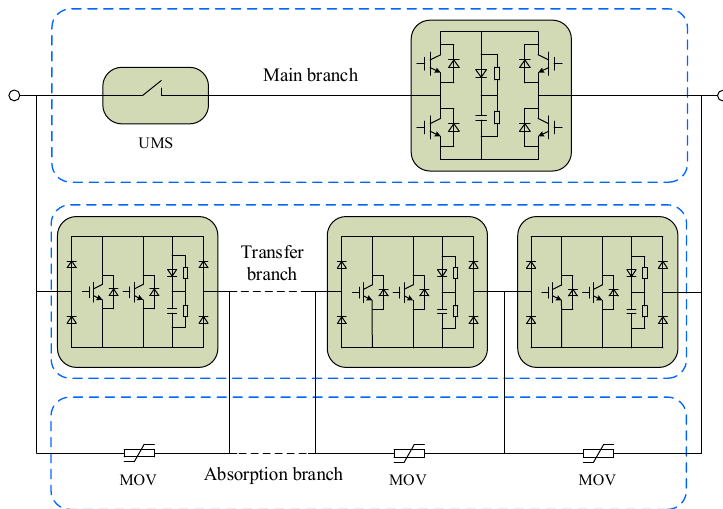
Figure 5. Basic structure of the hybrid DC breaker (HDCB).